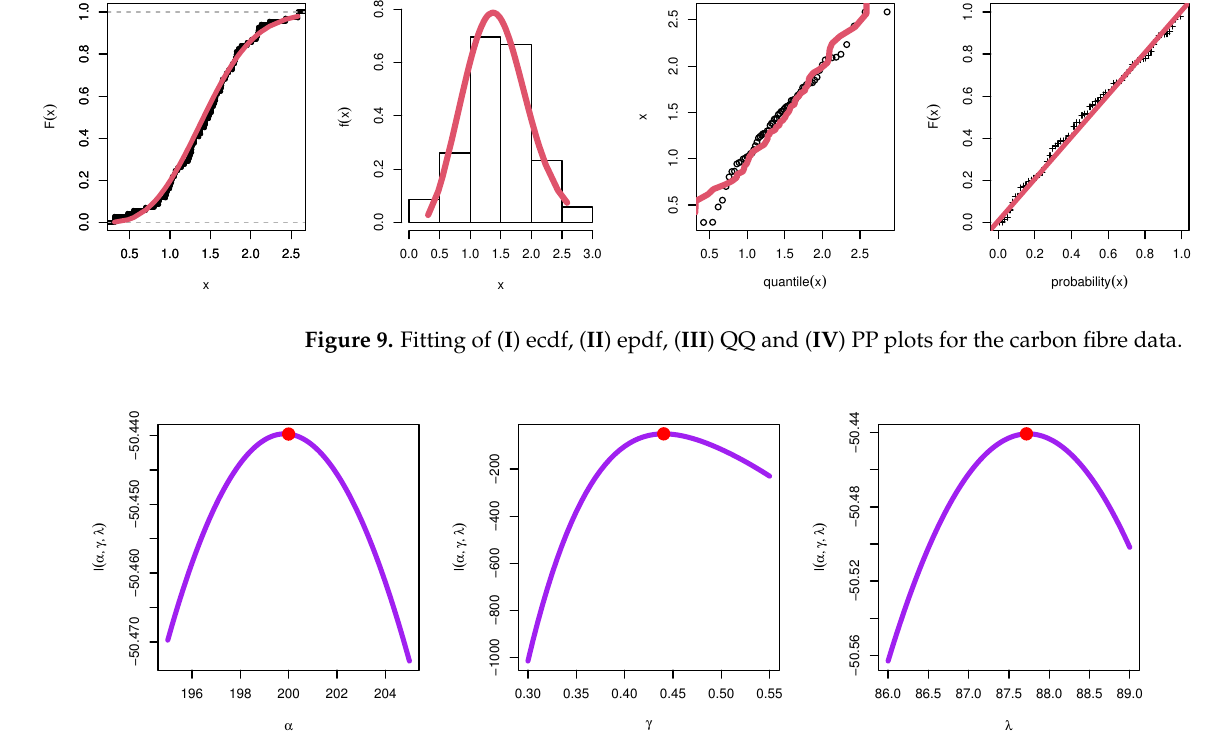
Figure 10. Profile likelihood α , γ , and λ for the carbon fibre data. Table 16. MLE for each model with different measures: carbon fibre